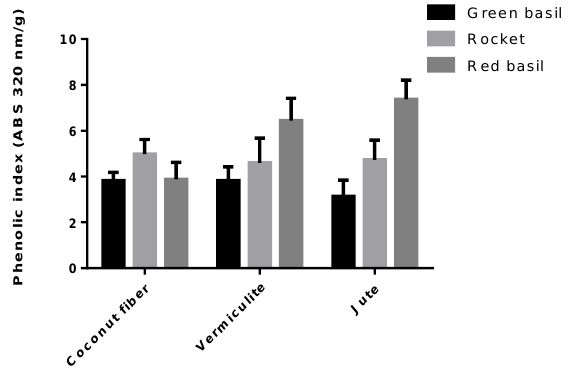
Figure 11. Phenolic index values of green basil, rocket, and red basil microgreens grown on three different substrates. Values, subjected to two-way ANOVA, are means ± SE (n = 6).